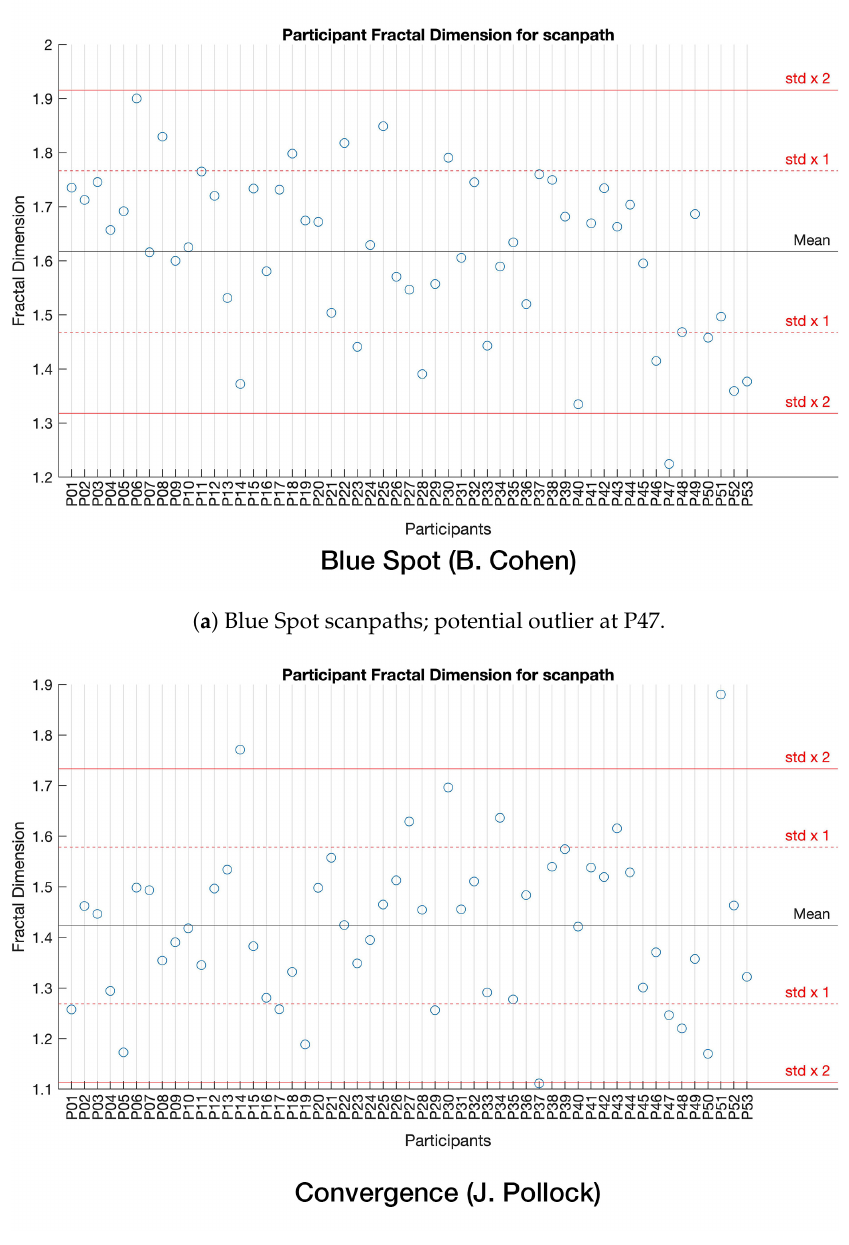
Figure 11. Scatter plot illustrating the geometric complexity ( y axis) of each participant’s scanpath ( x axis), for the purpose of outlier detection using methods from Newport et al. [37]. The black horizontal line in the approximate centre of the plot represents the mean geometric complexity. Red dotted lines represent either a 1 × or a 2 × standard deviation from the